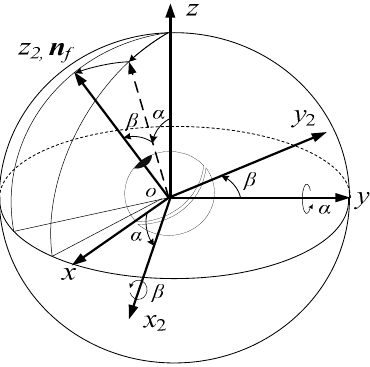
Figure 3. Posture representation of the